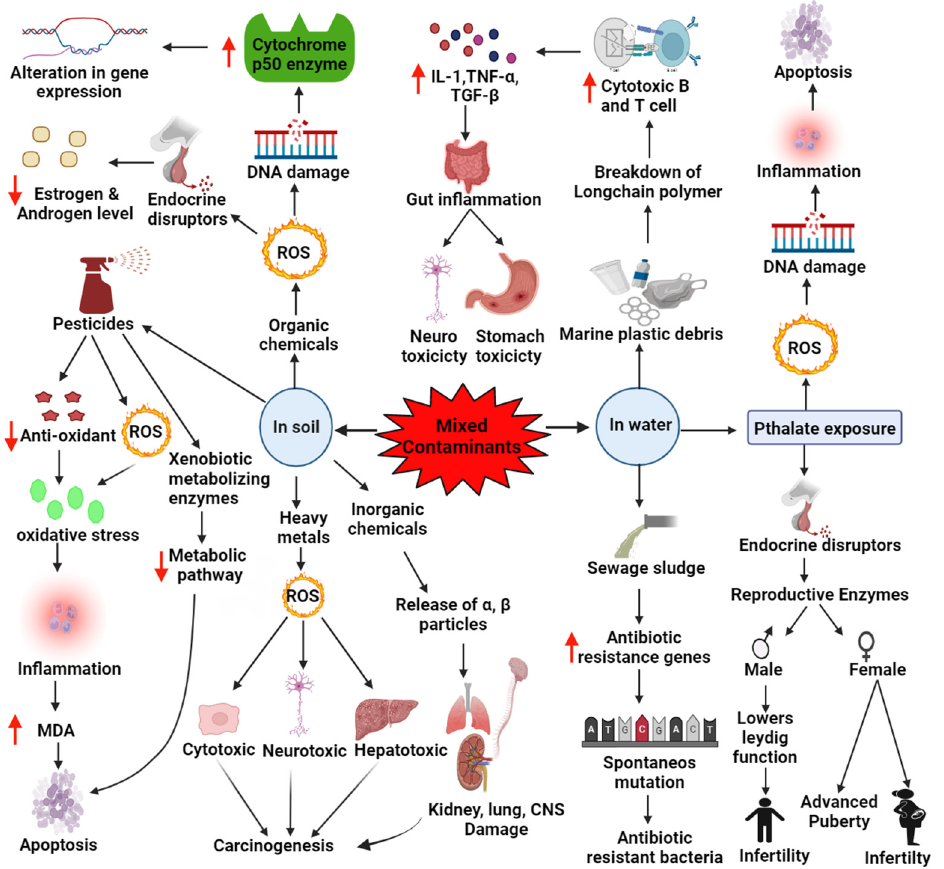
Figure 3. Effects of mixed contaminants in soil and water. Pathophysiology is followed by different contaminants in humans, eventually leading to cancer. Water contaminated with phthalate and its exposure to humans has resulted in various reproduction-related complications in males and females. Up arrow ( ) indicates increases and down arrow indicates ( ) decreases.